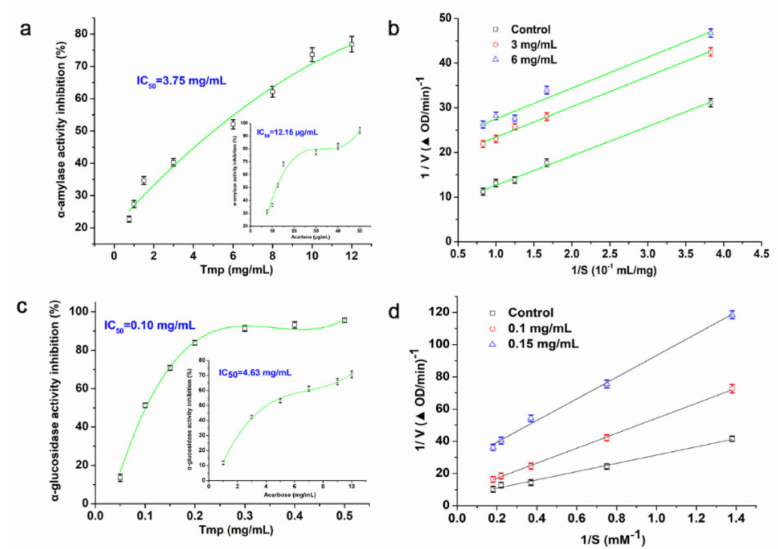
Figure 5. Inhibitory effect of Tmp on α -amylase activity ( a ). Inhibition kinetics of Tmp on α -amylase activity ( b ). Inhibitory effect of Tmp on α -glucosidase activity ( c ). Inhibition kinetics of Tmp on α -glucosidase activity ( d ). Acarbose was used as the positive